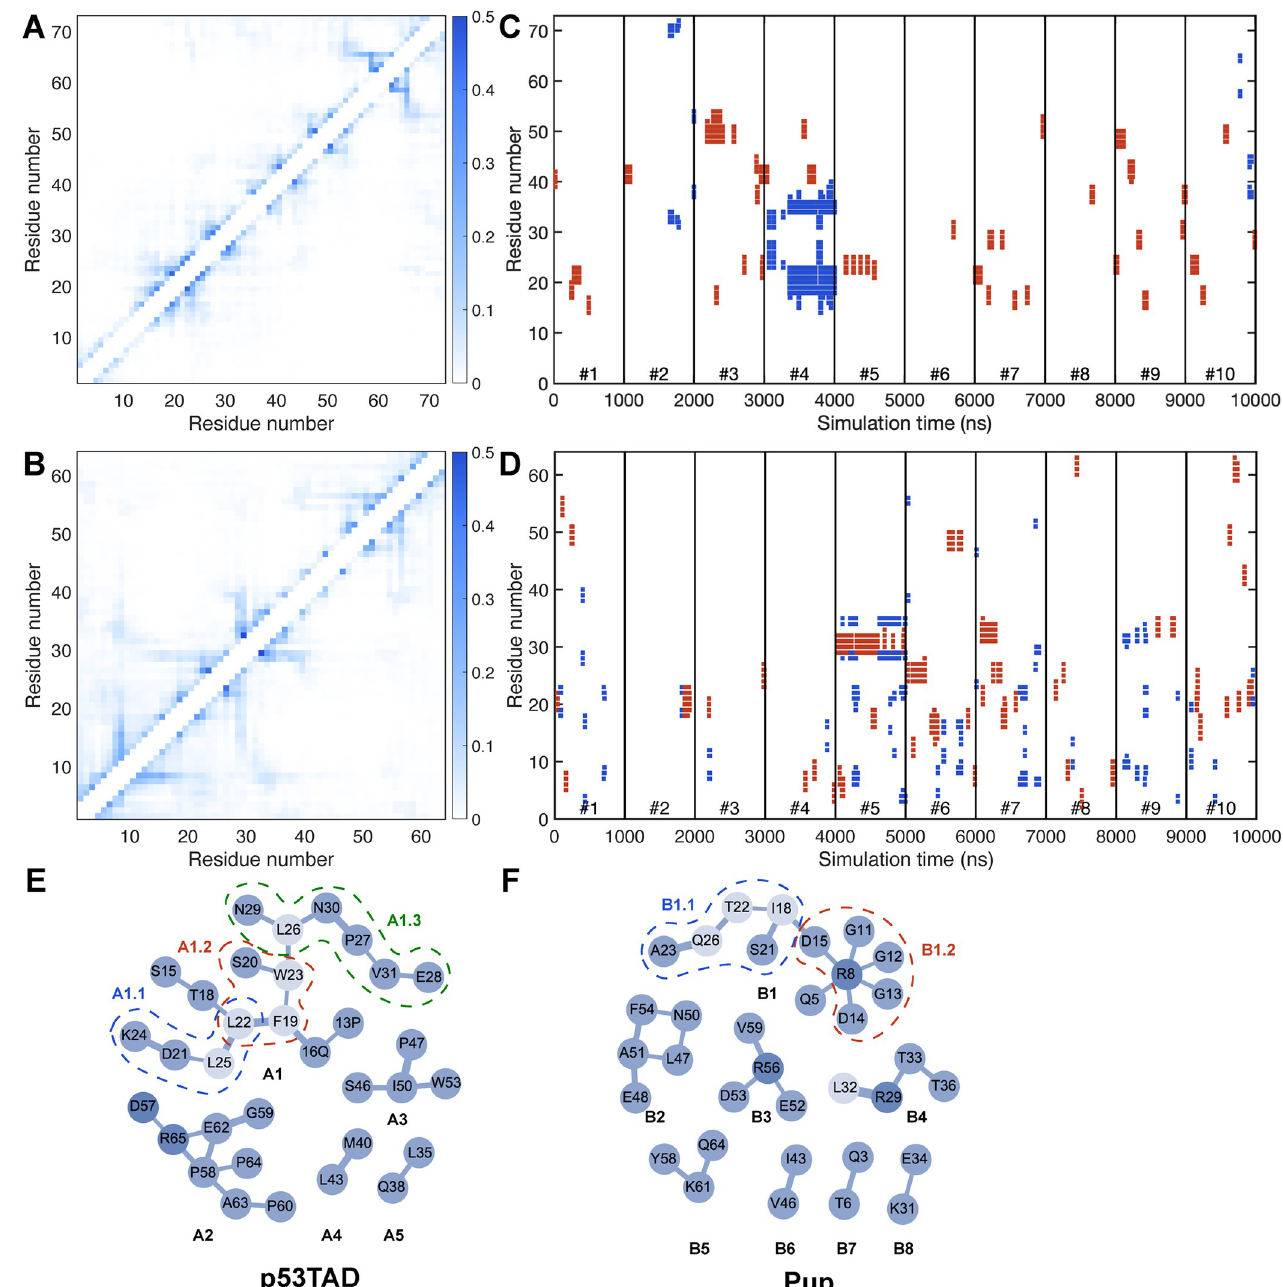
Fig 4. Average IDP contact maps and time-dependent secondary structure formation of each residue. (A, B) Pairwise contact occupancies were determined from MD simulations (without outlier trajectories, S2 Fig, S4 and S5 Tables ) for (A) p53TAD and (B) Pup. Darker/lighter shades of blue denote contacts that are more frequently/rarely formed according to legend (vertical bar). Self-contacts, first-neighbor contacts (between residues i , i +1), and second-neighbor contacts (between residues i , i +2) are not shown since they are present in most snapshots. (C, D) secondary structure of each residue in MD simulations are predicted using the DSSP algorithm with α -helices shown in red and β -strands in blue. (E, F) In the residue clusters at the bottom, pairwise contacts with occupancies > 0.2 are depicted as an edge connecting two nodes (residues) with edge widths proportional to the pairwise contact occupancies. Labels A1–A5 denote dominant clusters in p53TAD and B1–B8 in Pup. Examples of transiently formed subclusters are indicated by dashed lines (A1.1, A1.2, and A1.3 in p53TAD and B1.1 and B1.2 in Pup).